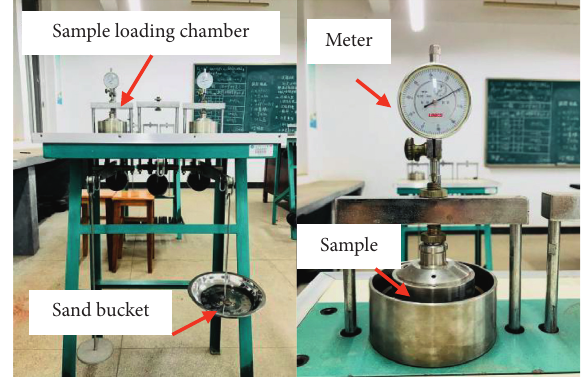
Figure 3: Consolidometer and sample loading